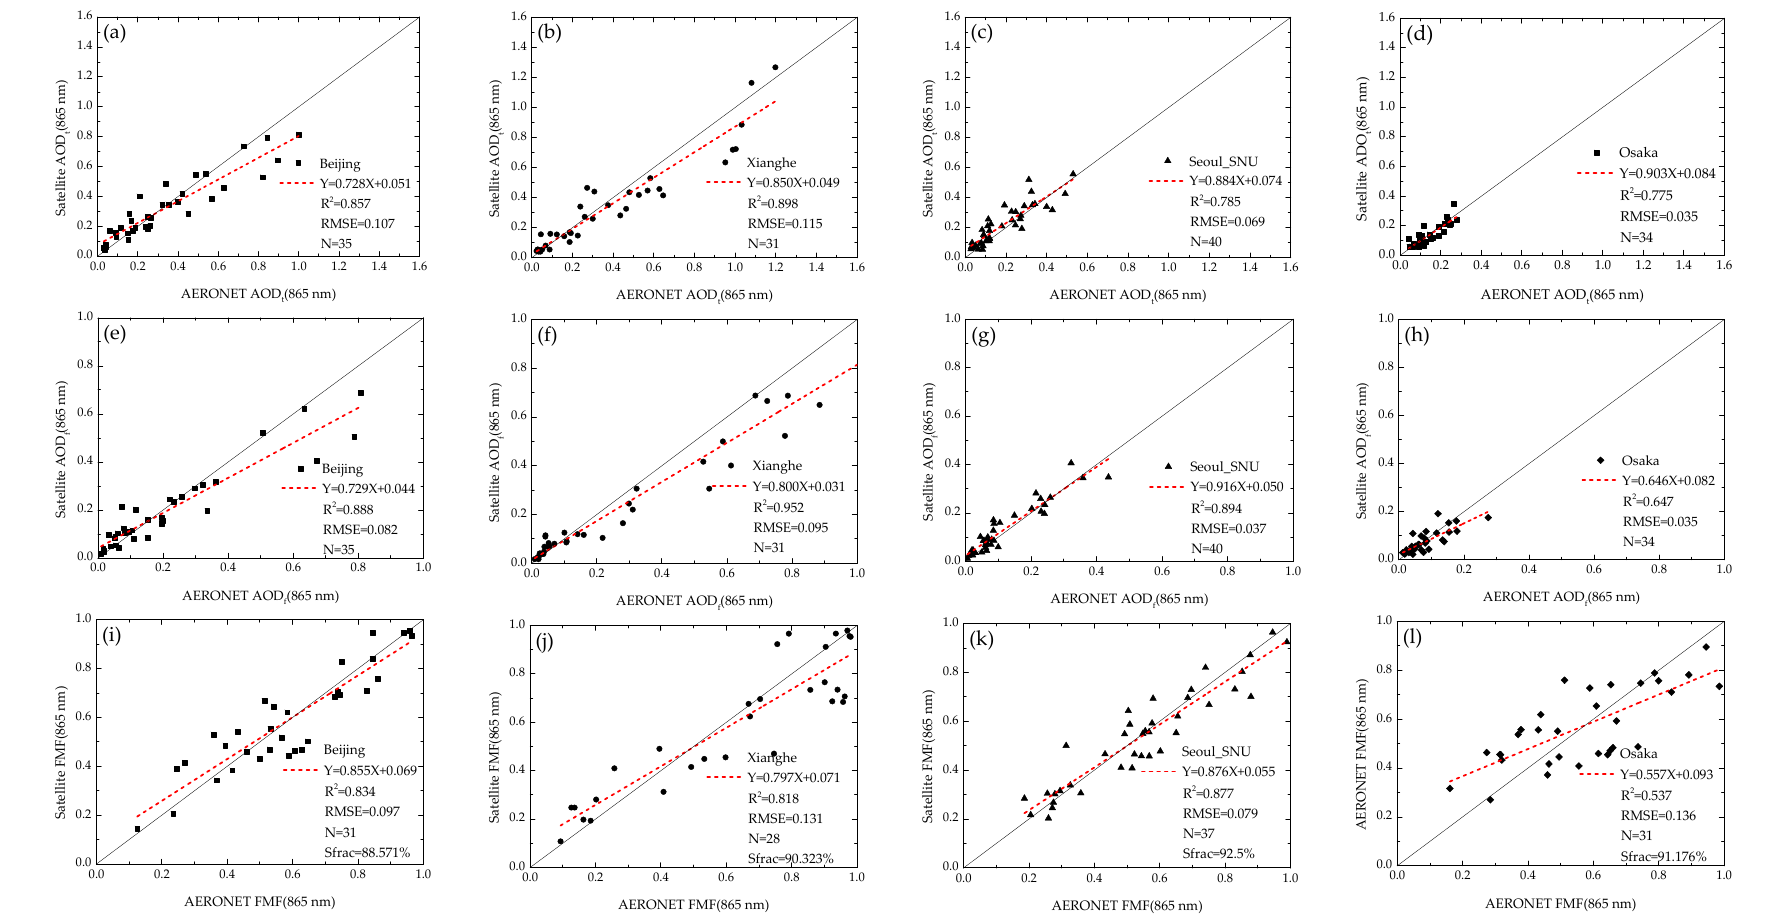
Figure 8. ( a – l ) The validation results of the Beijing, Xianghe, Seoul_SNU, and Osaka sites. ( a ), ( e ), and ( i ) are the validation results of the PARASOL total AOD (AODt), fine-mode AOD (AODf) and FMF of the Beijing site, respectively. ( b ), ( f ), and ( j ) are the validation results of the PARASOL AODt, AODf and FMF of the Xianghe site, respectively. ( c ), ( g ), and ( k ) are the validation results of the PARASOL AODt, AODf and FMF of the Seoul_SNU site, respectively. ( d ), ( h ), and ( l ) are the validation results of the PARASOL AODt, AODf, and FMF of the Osaka site, respectively.